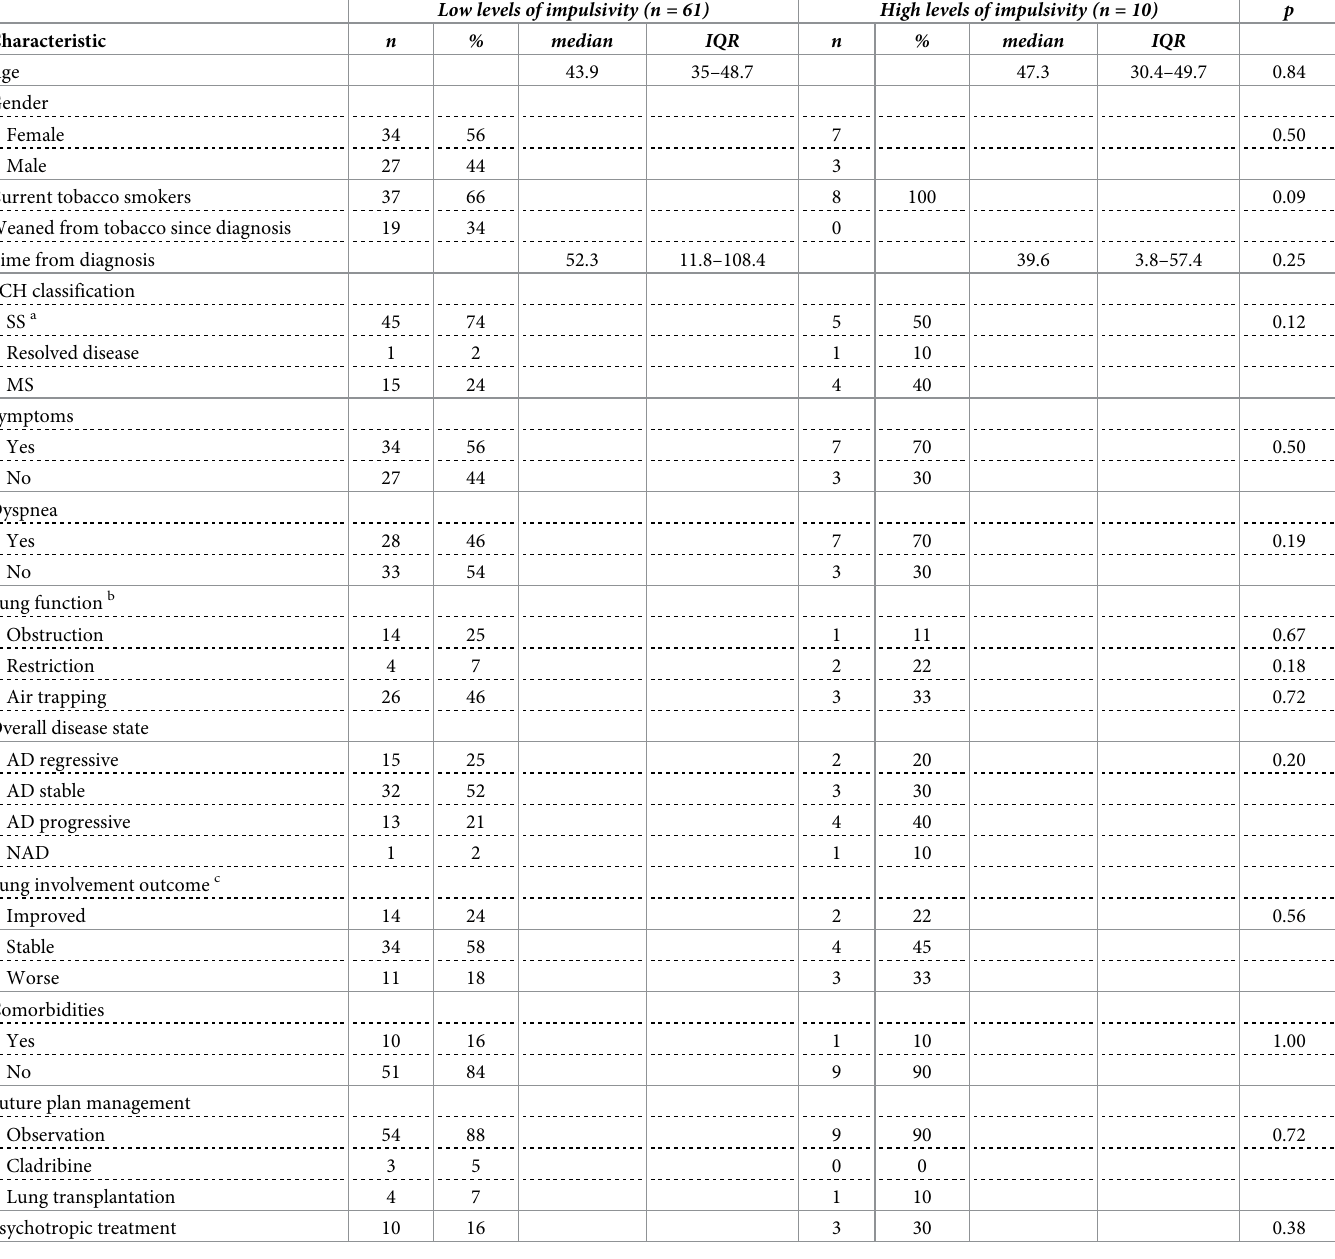
Table 5. Univariate analyses of the factors associated with barratt scores, considering a threshold score value greater than 68, corresponding to the median total score on the scale. Low levels of impulsivity (n =